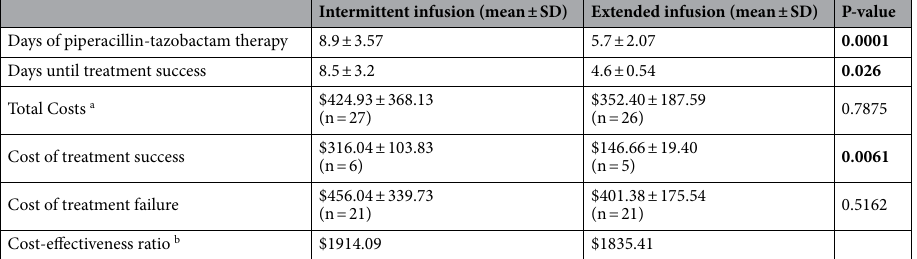
Table 5. Comparing costs of both arms. a Total cost in USD for preparations, supplies, drugs, and labor was obtained from the hospital during the year 2018–2019 b . Cost-effectiveness ratio = mean Total costs/ success rate. P-value ≤ 0.05 is considered statistically significant. Significant P-values are in bold.